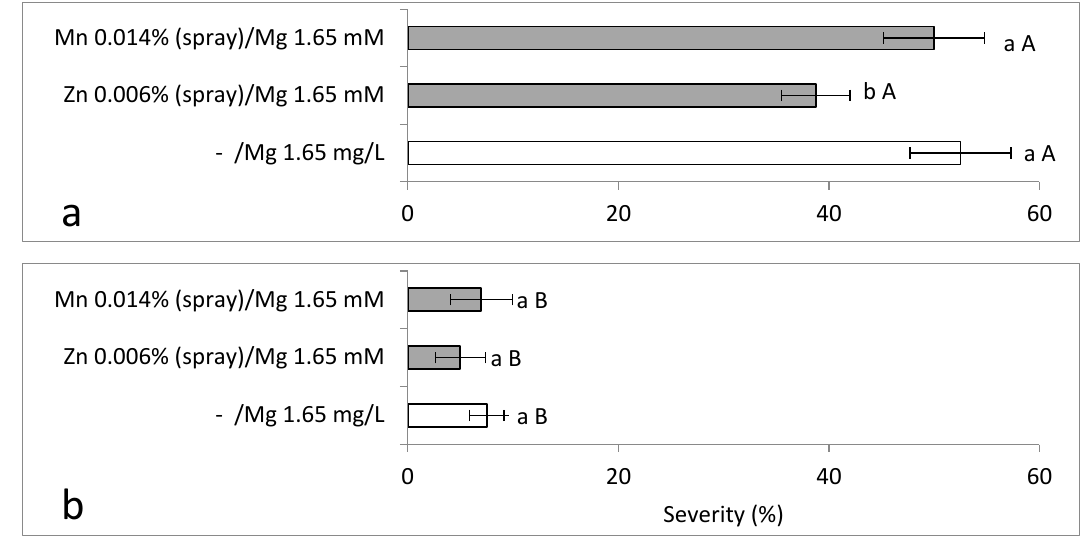
Figure 6. Effects of foliar applications of Zn-EDTA (0.006%), Mn-EDTA (0.014%) and fungicides on the severity of sweet basil downy mildew under commercial-like conditions (Autumn 2016). Plants were irrigated with a solution without added Mg (Mg concentration in water was regarded as 40 mg/L). Severity of SBDM at 93 days after planting ( a ) without fungicides and ( b ) with fungicides. Disease severity was evaluated on a 0–100% scale, in which 0 = healthy plants and 100% = plants completely covered by disease symptoms. Values within each graph that are followed by a different lower-case letter and values followed by a capital letter in each pair of treatments without and with fungicides are significantly different according to two-way ANOVA with Tukey’s HSD test. The interaction between the major parameters (fungicides × foliar-applied microelements) was significant, so detailed analyses of all of the combination treatments are presented. Default significance levels were set at p ≤ 0.05. Bar = SE.